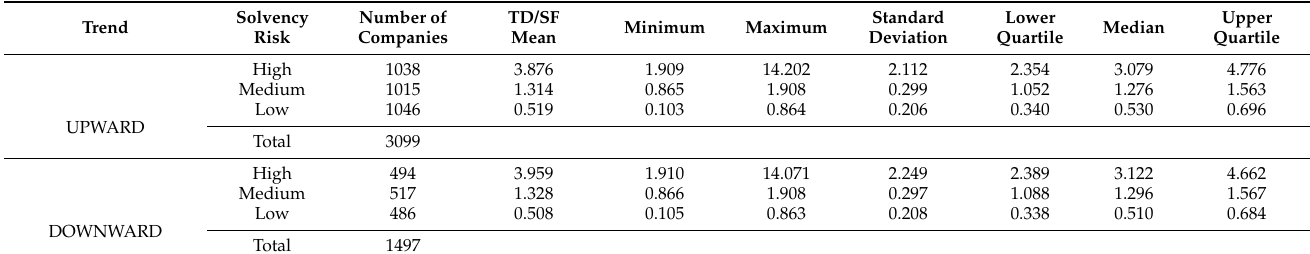
Table 3. Descriptive statistics of TD/SF based on 2011–2019 trend and solvency risk categories. Trend